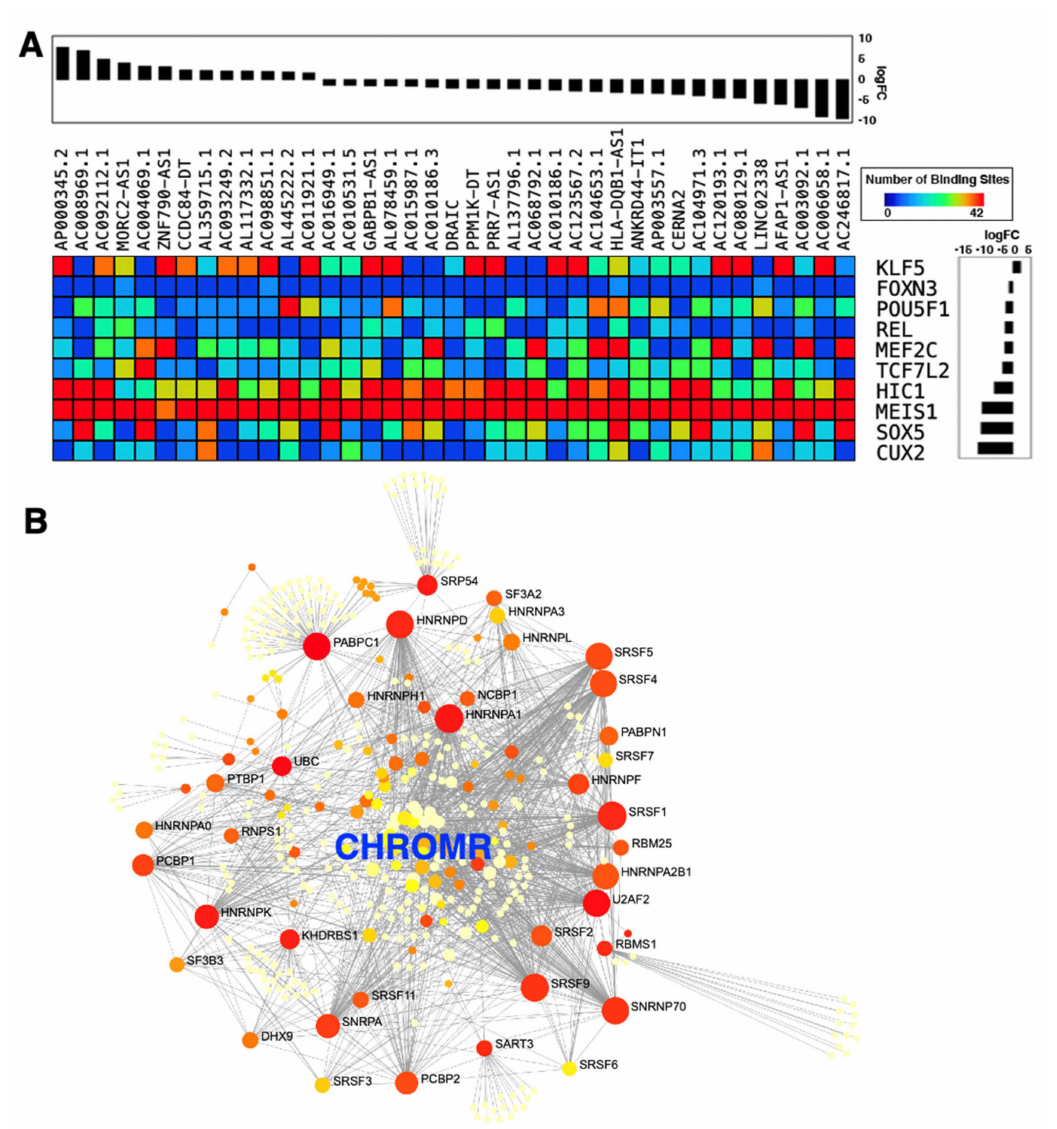
Figure 3. Molecular characteristics of differentially expressed lncRNAs in rituximab-resistant DLBCL cell lines compared to rituximab-sensitive cell lines. ( A ) Enrichment of transcription factor binding in the promoter regions of differentially expressed lncRNAs. The following 10 transcription factors with the highest number of binding sites in these promoter regions are shown in the image along with the log-transformed fold change (logFC) values in rituximab-resistant compared to rituximab-sensitive DLCBL cell lines: cut like homeobox 2 (CUX2); forkhead box N3 (FOXN3); HIC ZBTB transcriptional repressor 1 (HIC1); Kruppel like factor 5 (KLF5); myocyte enhancer factor 2C (MEF2C); Meis homeobox 1 (MEIS1); POU class 5 homeobox 1 (POU5F1); REL proto-oncogene, NF-kB subunit (REL); SRY-box transcription factor 5 (SOX5); and transcription factor 7 like 2 (TCF7L2). To allow for the visual inspection, 39 of 123 differentially expressed lncRNAs are shown along with the logFC values in rituximab-resistant compared to -sensitive DLCBL cell lines. ( B ) Protein-protein interactions (PPIs) of RNA-binding proteins (RBPs) predicted to bind CHROMR. PPIs are based on the information provided by the STRING database [99] visualized through NetworkAnalyst